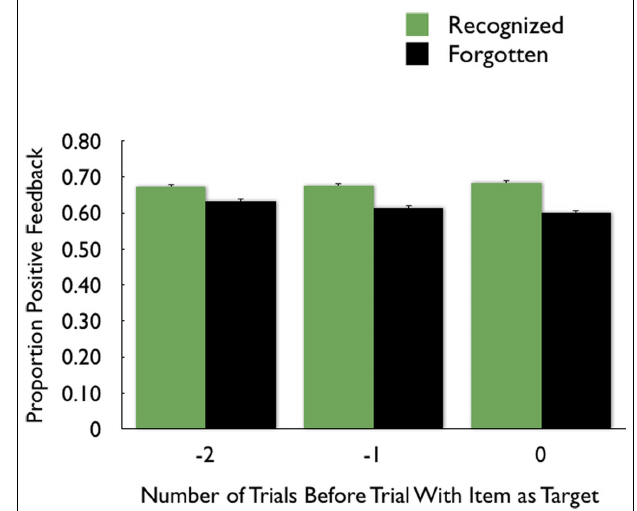
FIGURE 5 |The proportion of recognized pictures compared with forgotten pictures that had been preceded by trials two back ( − 2) that had positive feedback; the proportion with positive feedback on the preceding trial ( − 1) and the proportion with positive feedback on the same trial